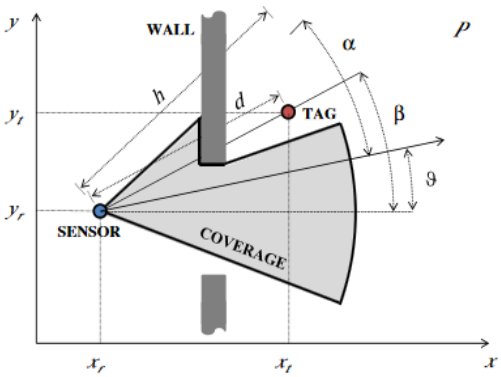
Fig. 5. Sensor coverage with the presence of a wall between the sensor and the tag